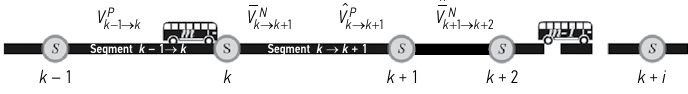
Fig. 5. An example of predicting arrival time at downstream stop k + 2